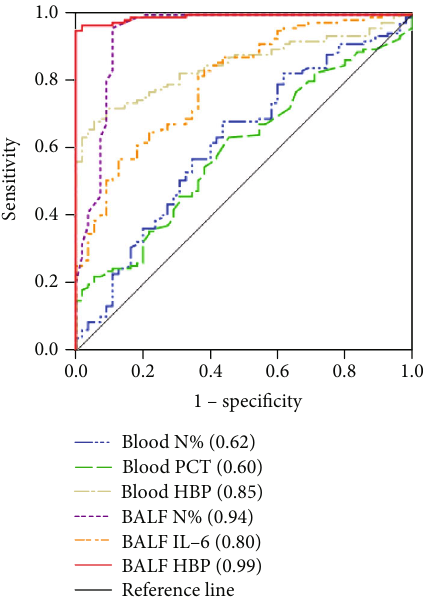
Figure 3: ROC curves for biomarkers in blood and BALF for predicting bacterial pneumonia. HBP: heparin-binding protein; CRP: C-reactive protein; IL-6: interleukin-6; PCT: procalcitonin; WBC: white blood cell count; N%: neutrophil percentage; BALF: bronchoalveolar lavage fl